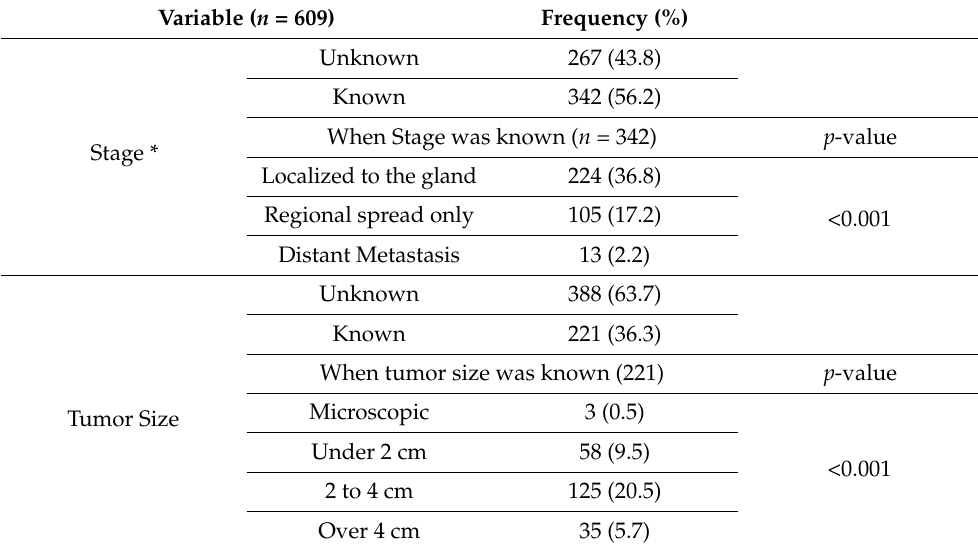
Table 2. Tumor characteristics and metastasis of 609 patients with parathyroid cancer from the Sur- veillance, Epidemiology, and End Results (SEER) database, 1975–2016.